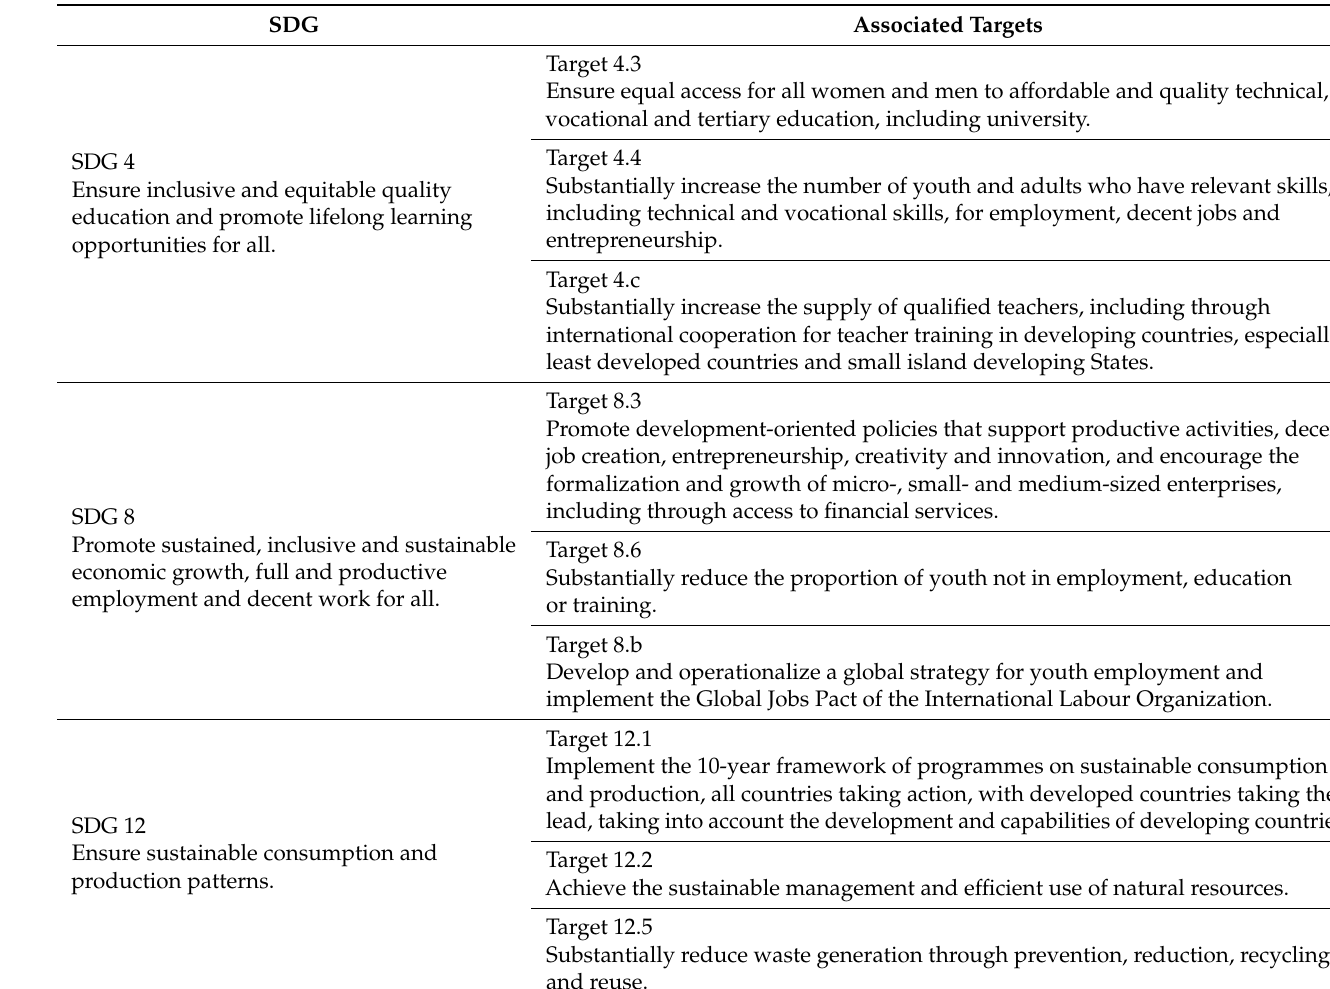
Table 2. SDG and associated targets that can be furthered through the use of the described ICT-based didactic tools. SDG Associated Targets Target